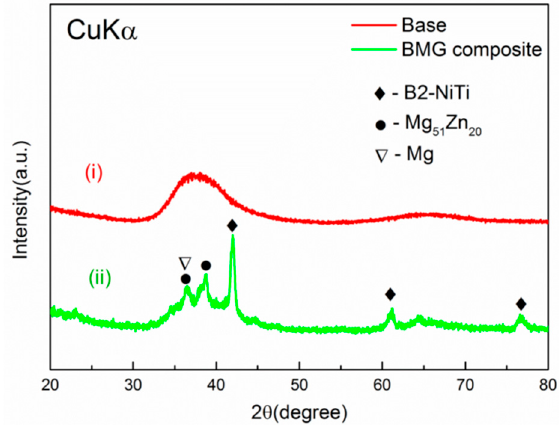
Figure 1. XRD patterns for both ( i ) base alloy and ( ii ) composite with 3 vol.% porous NiTi addition.